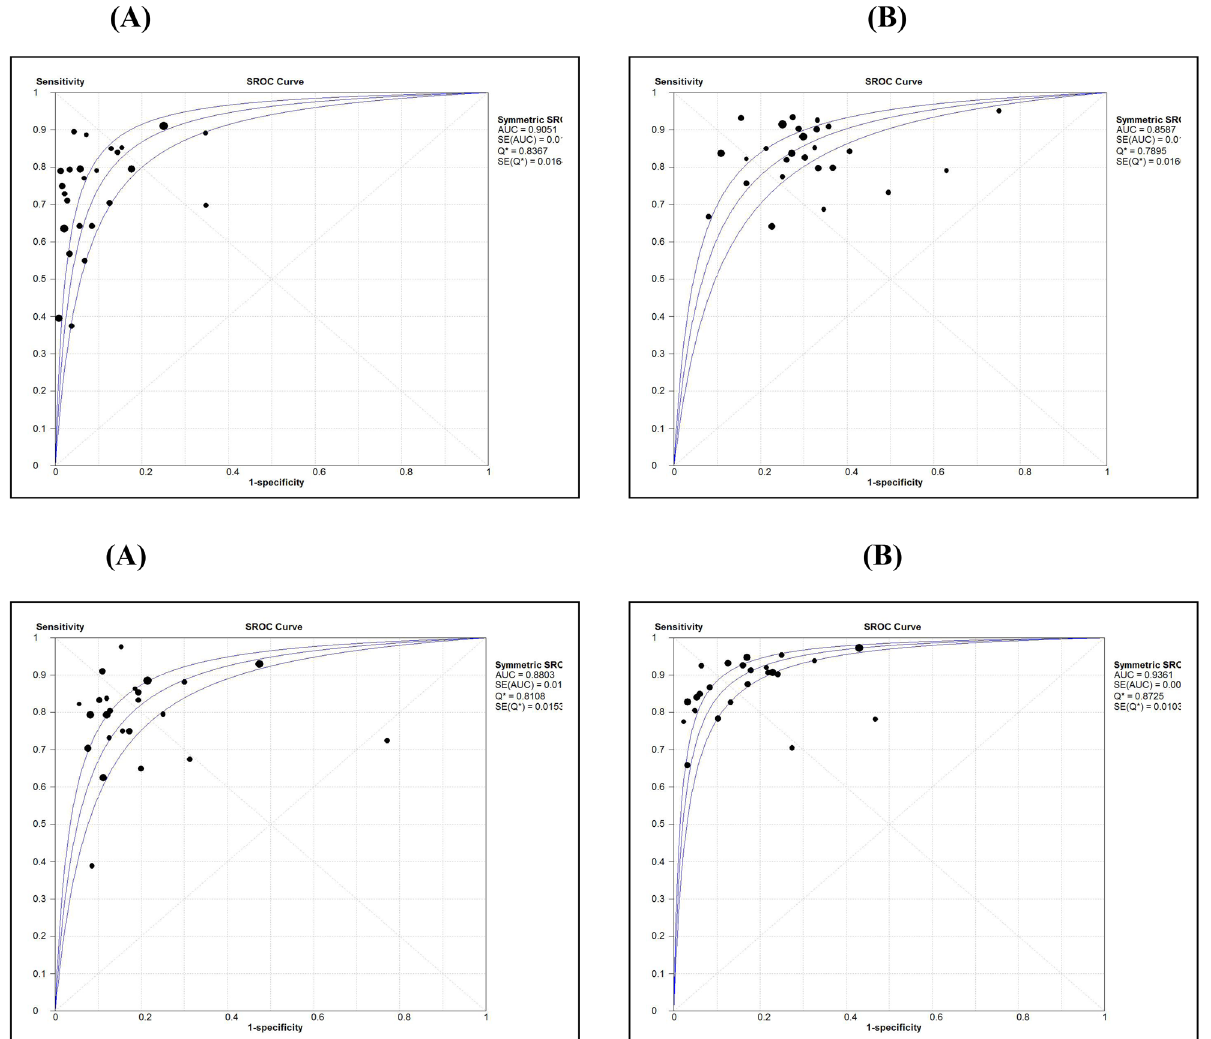
Figure 8. Comparison of Area Under Curve (AUC) by symmetric ROC analysis for HE4 ( A ), CA125 ( B ), ROMA for pre-menopause ( C ) and ROMA for post-menopause ( D ).